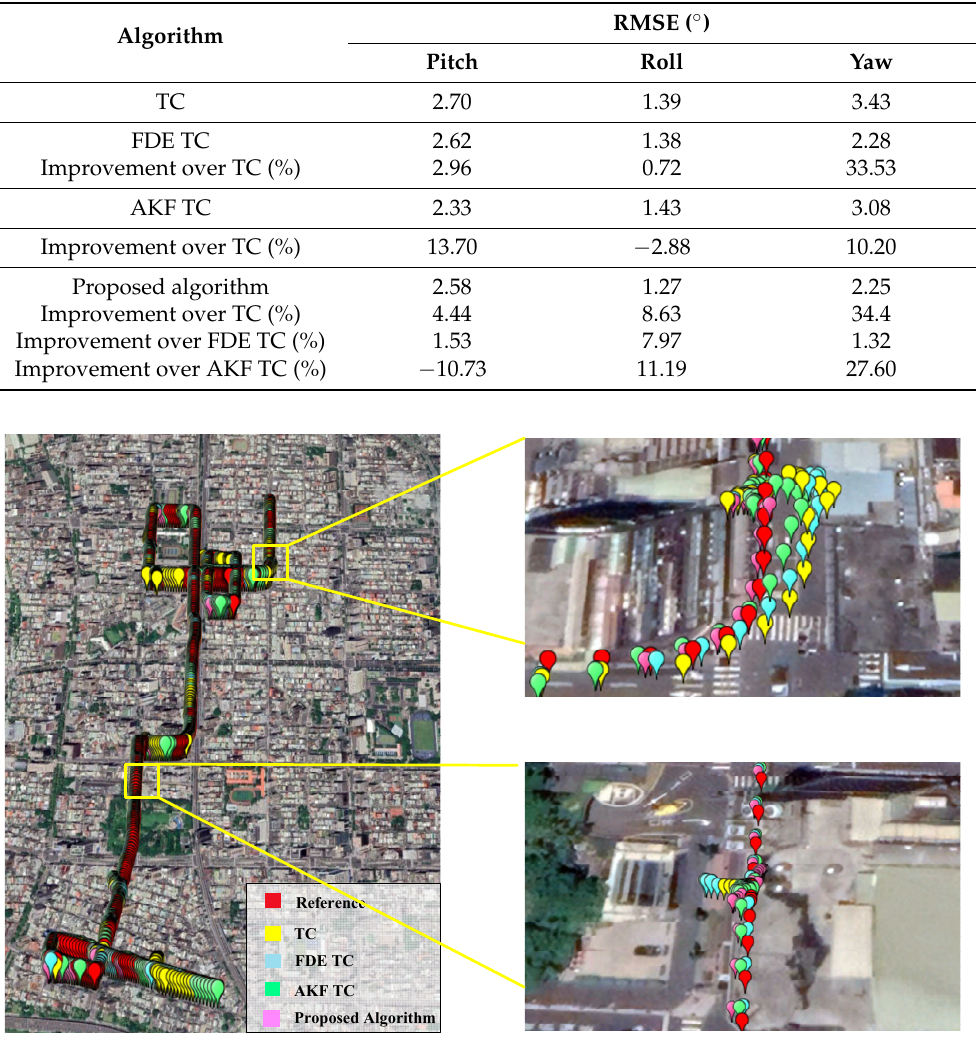
Figure 11. Trajectory comparison for TC, FDE LC, AKF TC, and the proposed algorithm in field test.